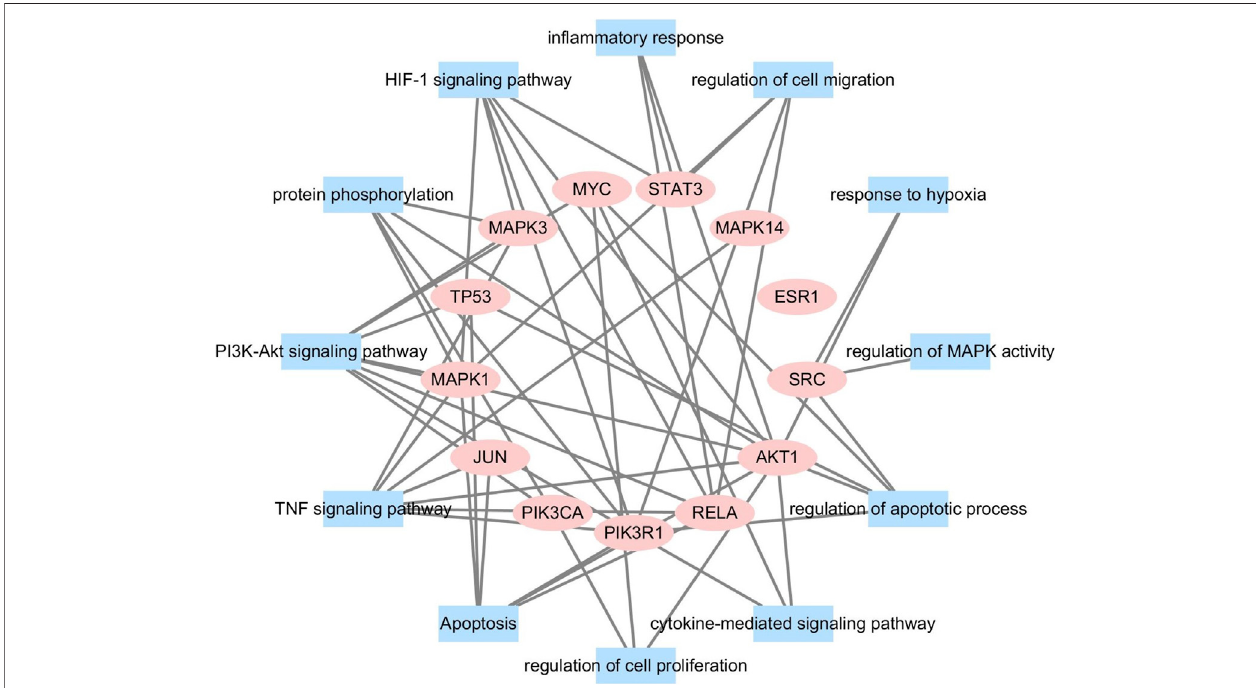
FIGURE 4 | A functional module is linked to the target if the target is involved in that biological process or